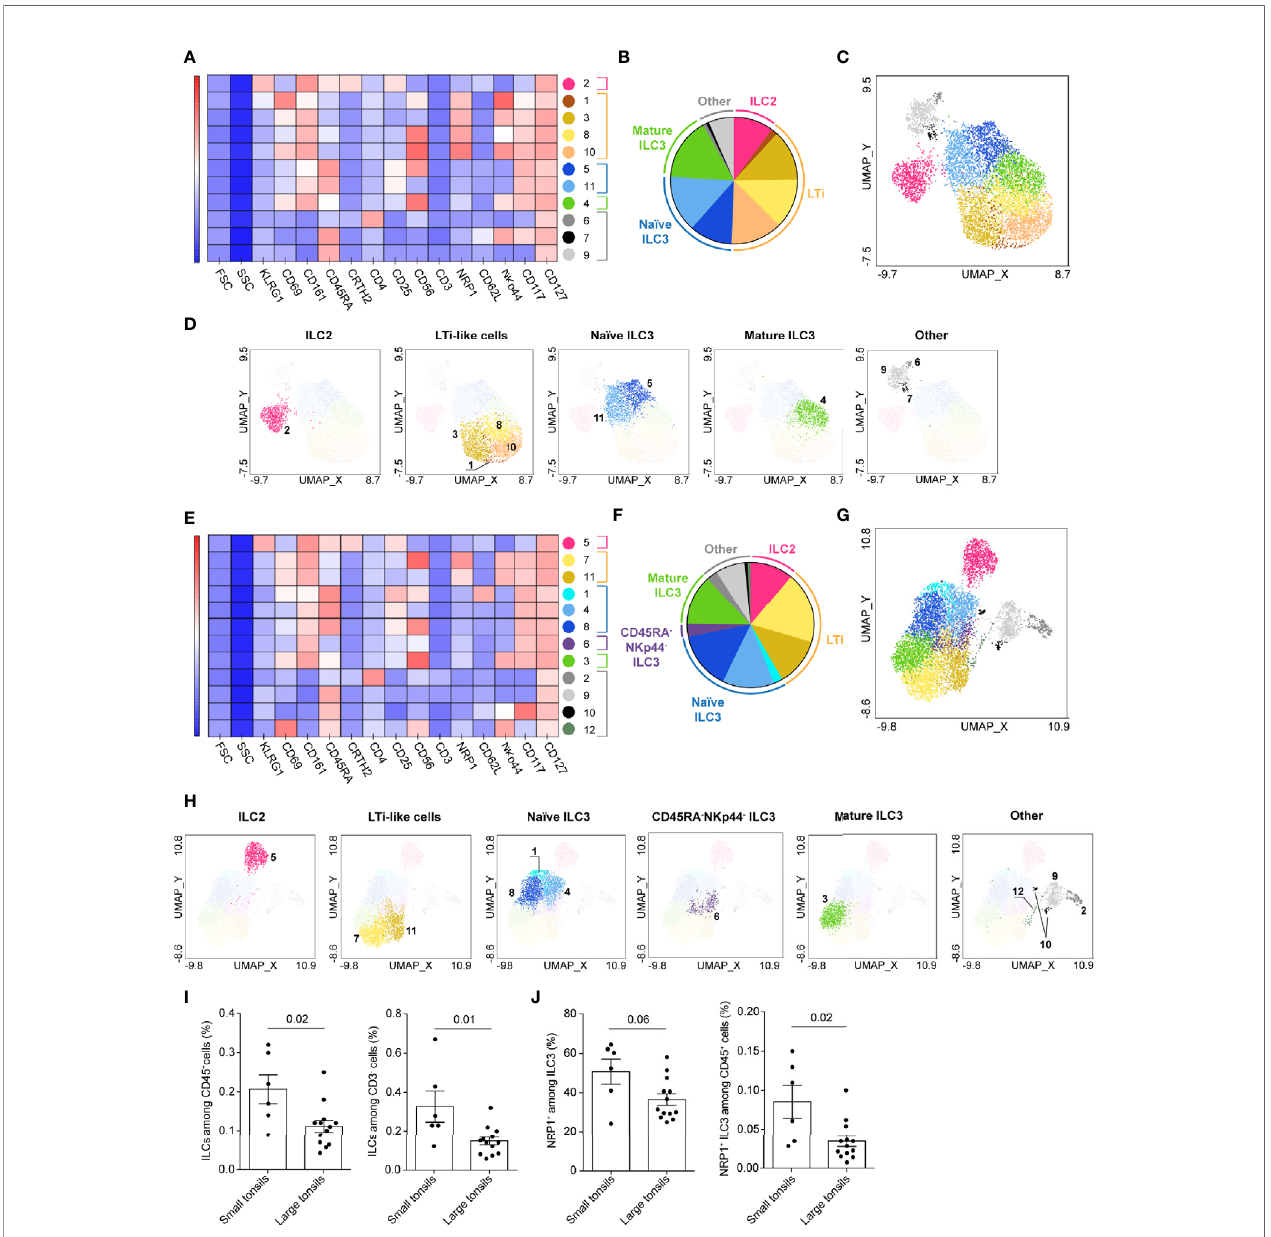
FIGURE 2 | CD127 + ILC clusters in tonsils of pediatric patients with OSA. (A – H) CD127 + ILC clusters in small (A – D) and large (E – H) tonsils from patients with OSA, identi fi ed by PhenoGraph in the concatenated fi les. (A, E) Heatmap of marker expression intensity scaled individually for each marker. (B, F) Diagram showing proportions of PhenoGraph clusters and combined functional groups. (C, D, G, H) PhenoGraph clusters overlaid on the corresponding UMAP together (C, G) or separated by functional group (D, H) . (I) Frequency of ILCs among total living CD45 + cells and CD3 - cells. (J) Frequency of NRP1 + ILC3 subset among ILC3 and total living CD45 + cells. (I, J) Bars and error bars indicate mean ± SEM. Statistical signi fi cance was calculated using Mann-Whitney U